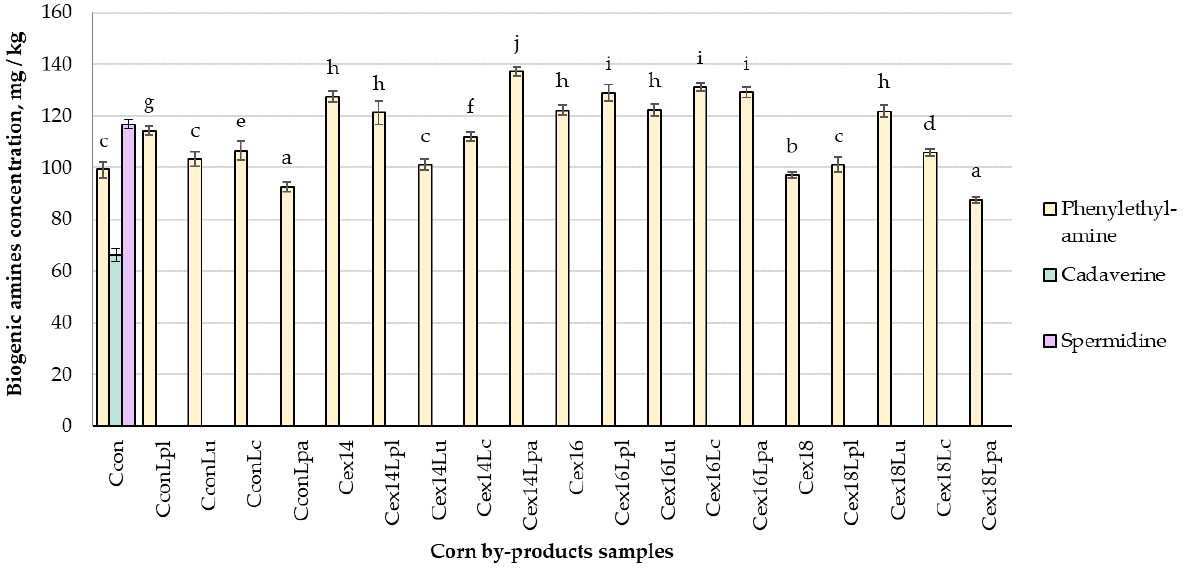
Figure 2. Biogenic amines mass concentration in corn by-products C—corn by-product samples; con—control samples (non-extruded non-fermented); Lpl, Lu, Lc, Lpa—fermented with L. plantarum - LUHS122, L. uvarum -LUHS245, L. casei -LUHS210, and L. paracasei -LUHS244 strains, respectively; ex—extruded samples; 14, 16, 18—moisture content of the corn by-product samples. Data are represented as means ( n = 3) ± SE. a–j—mean values denoted with different letters are significantly different between samples ( p ≤ 0.05).